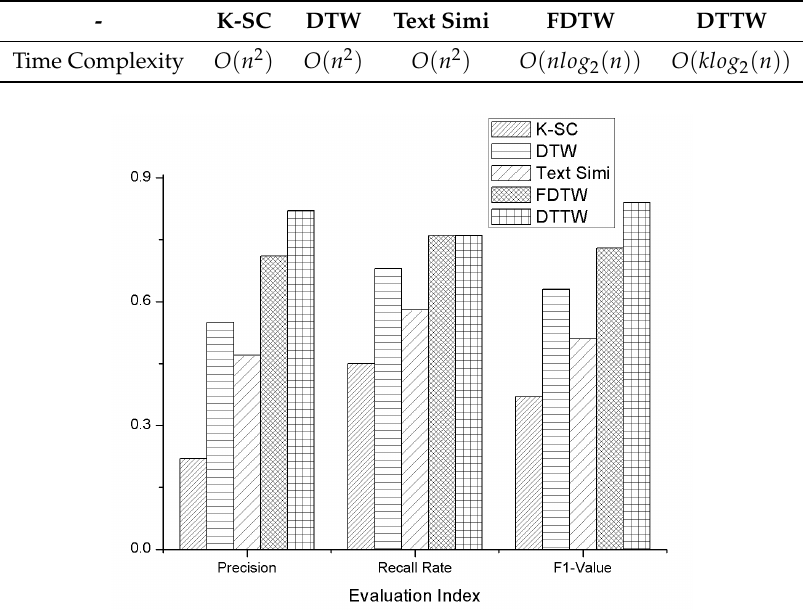
Figure 6. Comparison of clustering